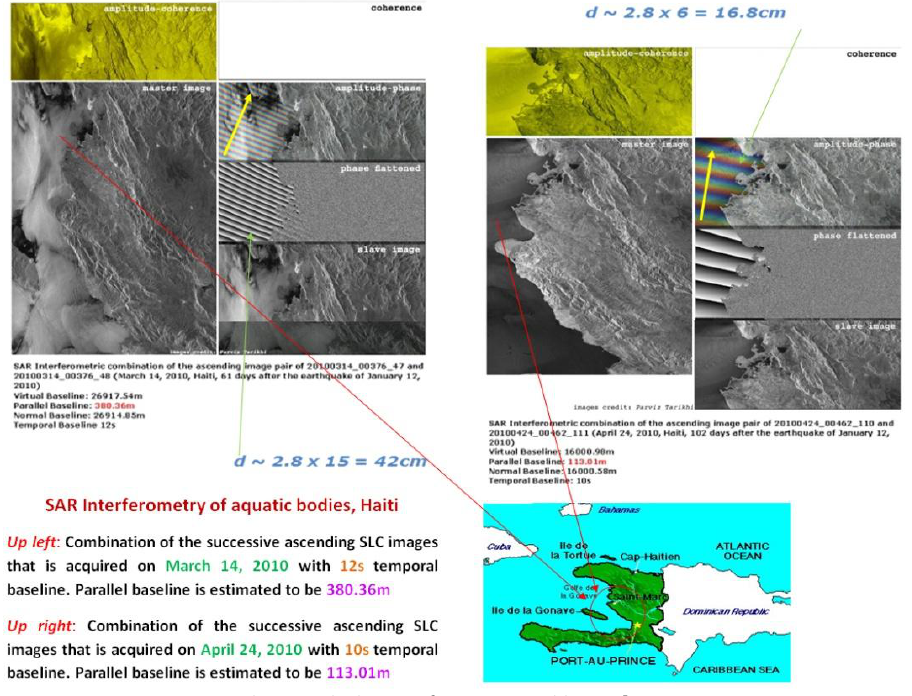
Figure 7: Liqui-InSAR for Western Haiti coastal zone